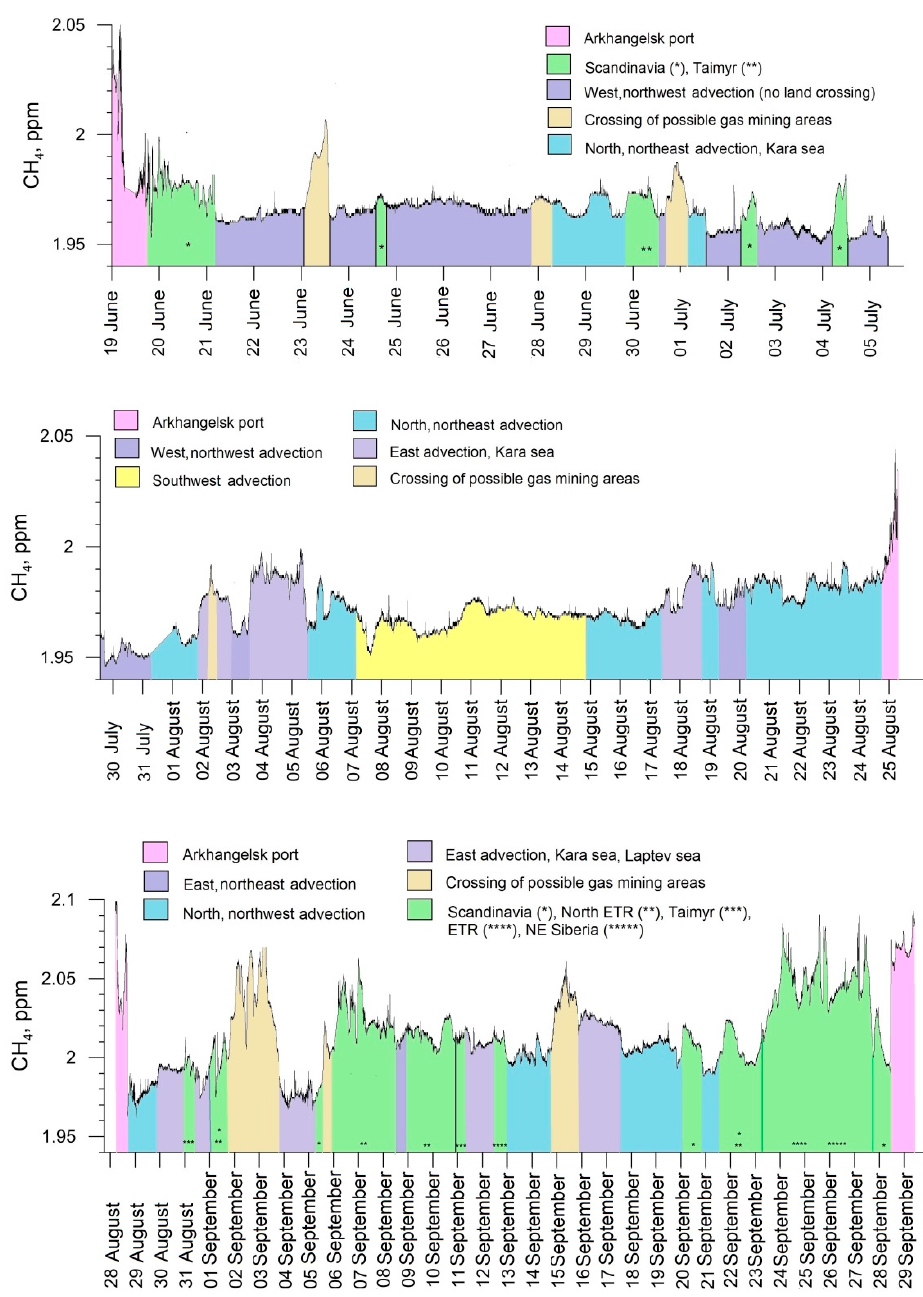
Figure 5. CH 4 mole fraction depending on direction of atmospheric flow for AMK-83, AMK-84, and AMK-85. The color indicates the geographic areas and the direction of transport according to the 120 h NOAA Hysplit backward trajectories. In some cases, the trajectory covered several regions; the corresponding asterisks (*) correspond to such periods on the graphs.